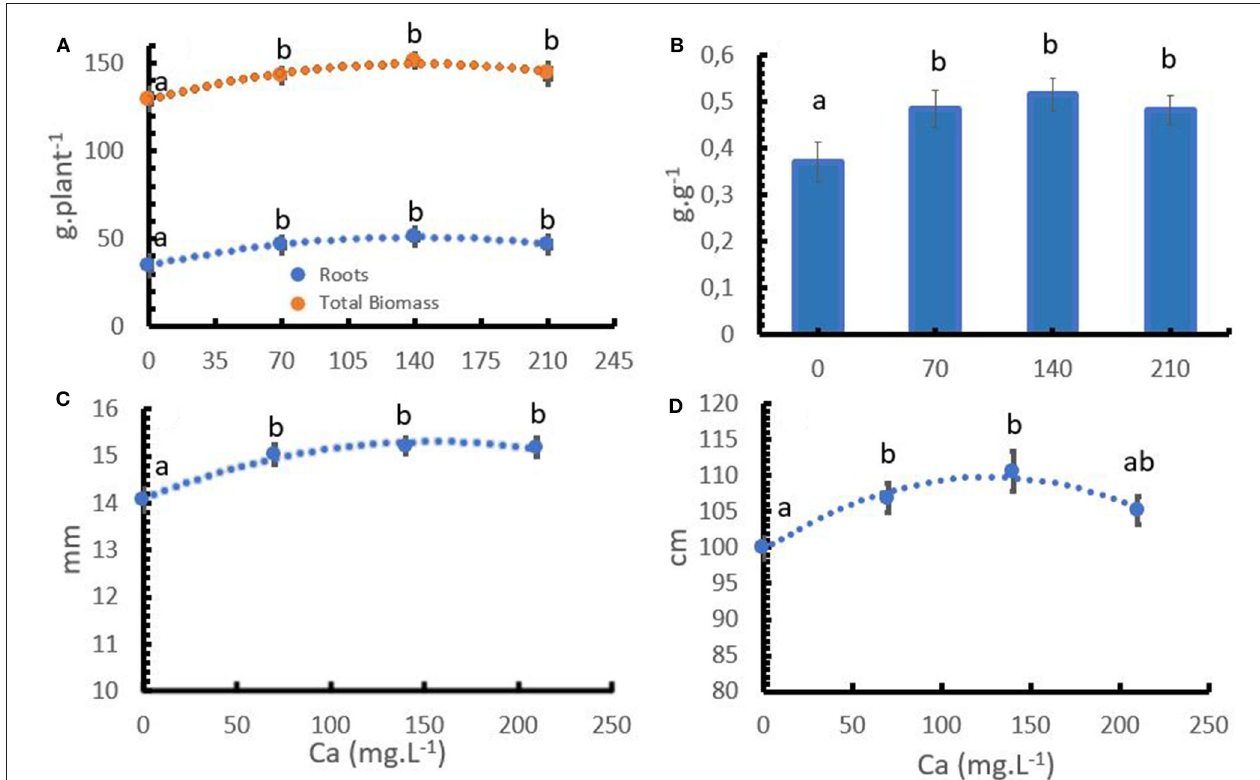
FIGURE 1 | Effect of the calcium (Ca + 2 ) and coffee dry biomass accumulation (A) , root: shoot ratio (B) , stem diameter (C) , and plant height (D) . Points and bars represent the mean values for each of the replicates ± standard error. Different letters represent statistically significant differences among the treatments ( P < 0.05, LSD fisher).